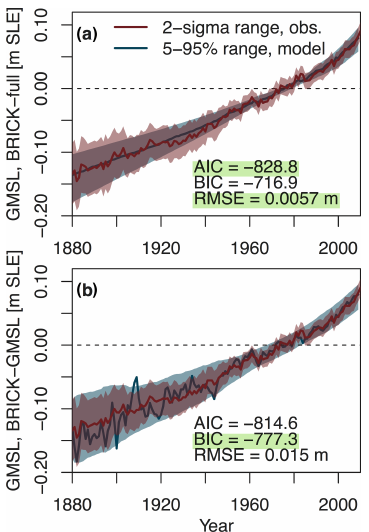
Figure 2. Comparison of global mean sea-level rise hindcast skill relative to sea-level data (Church and White, 2011), using (a) the full sub-model approach (GIC, GIS, TE, and AIS) and (b) the model for global mean sea-level rise of Rahmstorf (2007). Sea level is rel- ative to 1961–1990 global mean sea level. Both model configura- tions use DOECLIM as the climate module. Lower values of the Akaike information criterion (AIC), the Bayesian information cri- terion (BIC), and root-mean-squared error (RMSE) indicate a better model fit to the data. These error metrics are all calculated using the maximum likelihood ensemble member, which is represented by the solid blue line. Green highlighting indicates the model structure suggested by each comparison